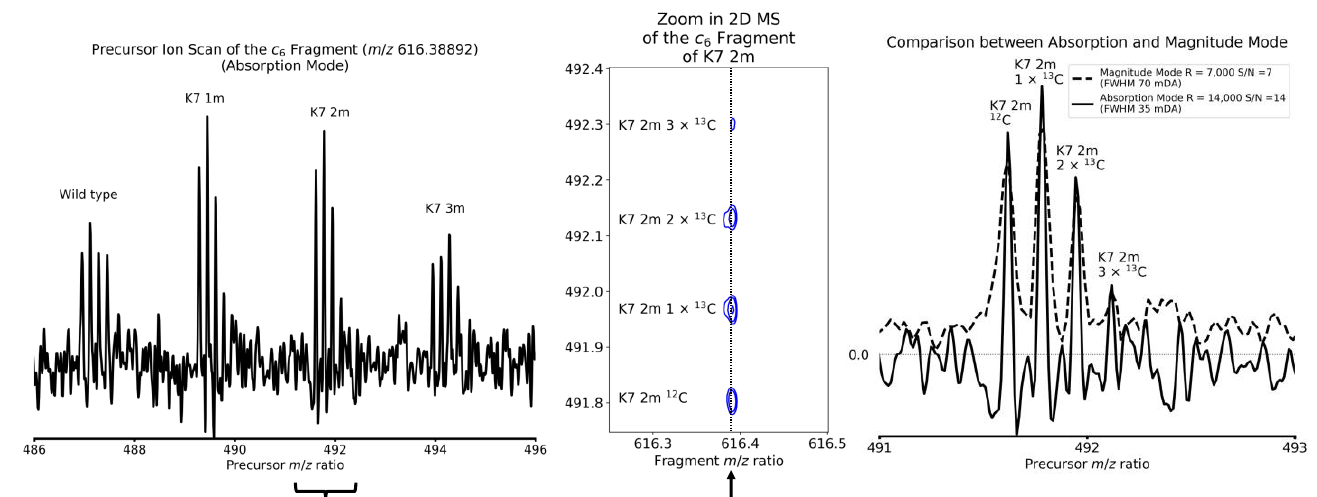
Figure 3. Precursor ion scan extracted from the absorption mode 2D mass spectrum for the 12 C isotope of the c 6 fragment of the histone peptides ( m/z 616.38892), zoom-in on the c 6 fragment ion isotopic distribution in the 2D mass spectrum for the dimethylated histone peptide (K7 2m), comparison between the absorption mode and magnitude mode of the precursor ion scan of the c 6 fragment.